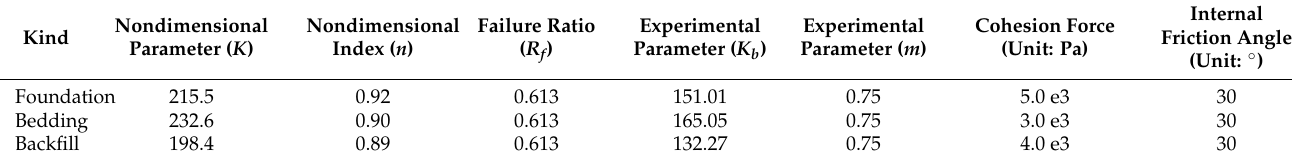
Table 4. Dun-Chang E-B constitutive model coefficients of